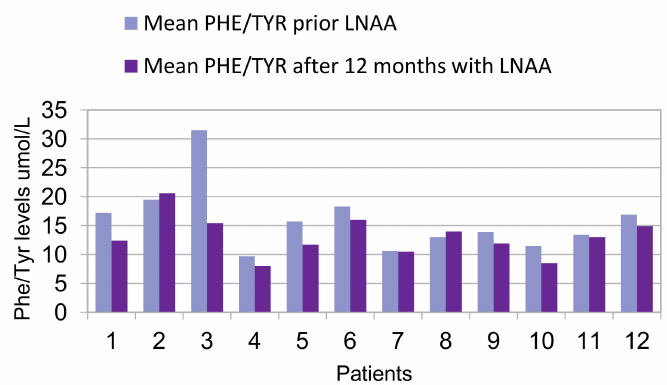
Figure 3. Mean Phe / Tyr ratio 12 months prior and after LNAA introduction for each